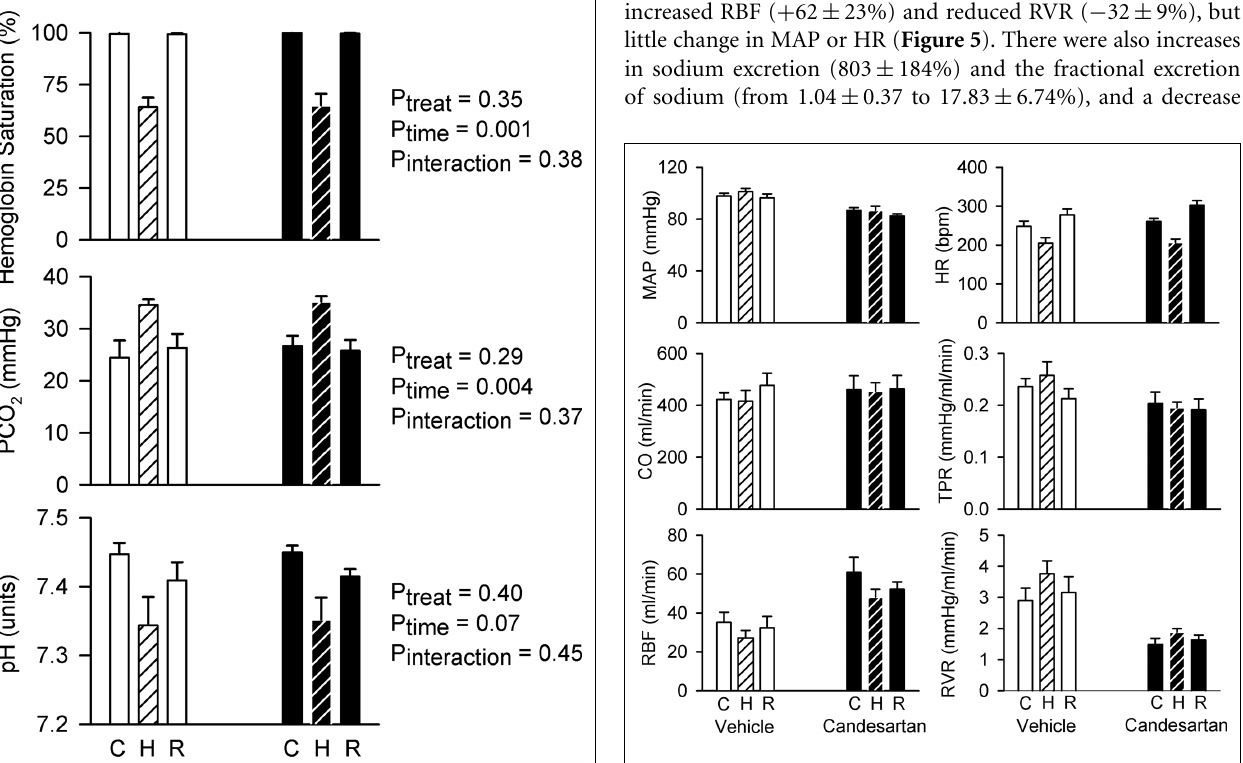
FIGURE 2 | Responses of hemodynamic variables to hypoxia in conscious rabbits treated with candesartan or its vehicle. MAP, mean arterial pressure; HR, heart rate; CO, cardiac output; RBF, renal blood flow; TPR, total peripheral resistance; RVR, renal vascular resistance; C, control; H, hypoxia; R, recovery. P values for the outcomes of two-way repeated measures analysis of variance are shown in Table 2 .These indicate significant effects of candesartan on MAP, RBF,TPR, and RVR, and a significant effect of hypoxia on HR. However, candesartan did not significantly affect responses to